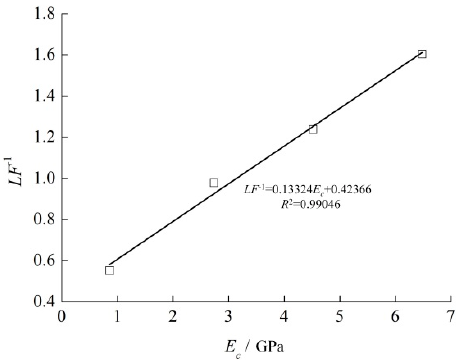
Figure 13. Relationship between elastic modulus and loading factor.